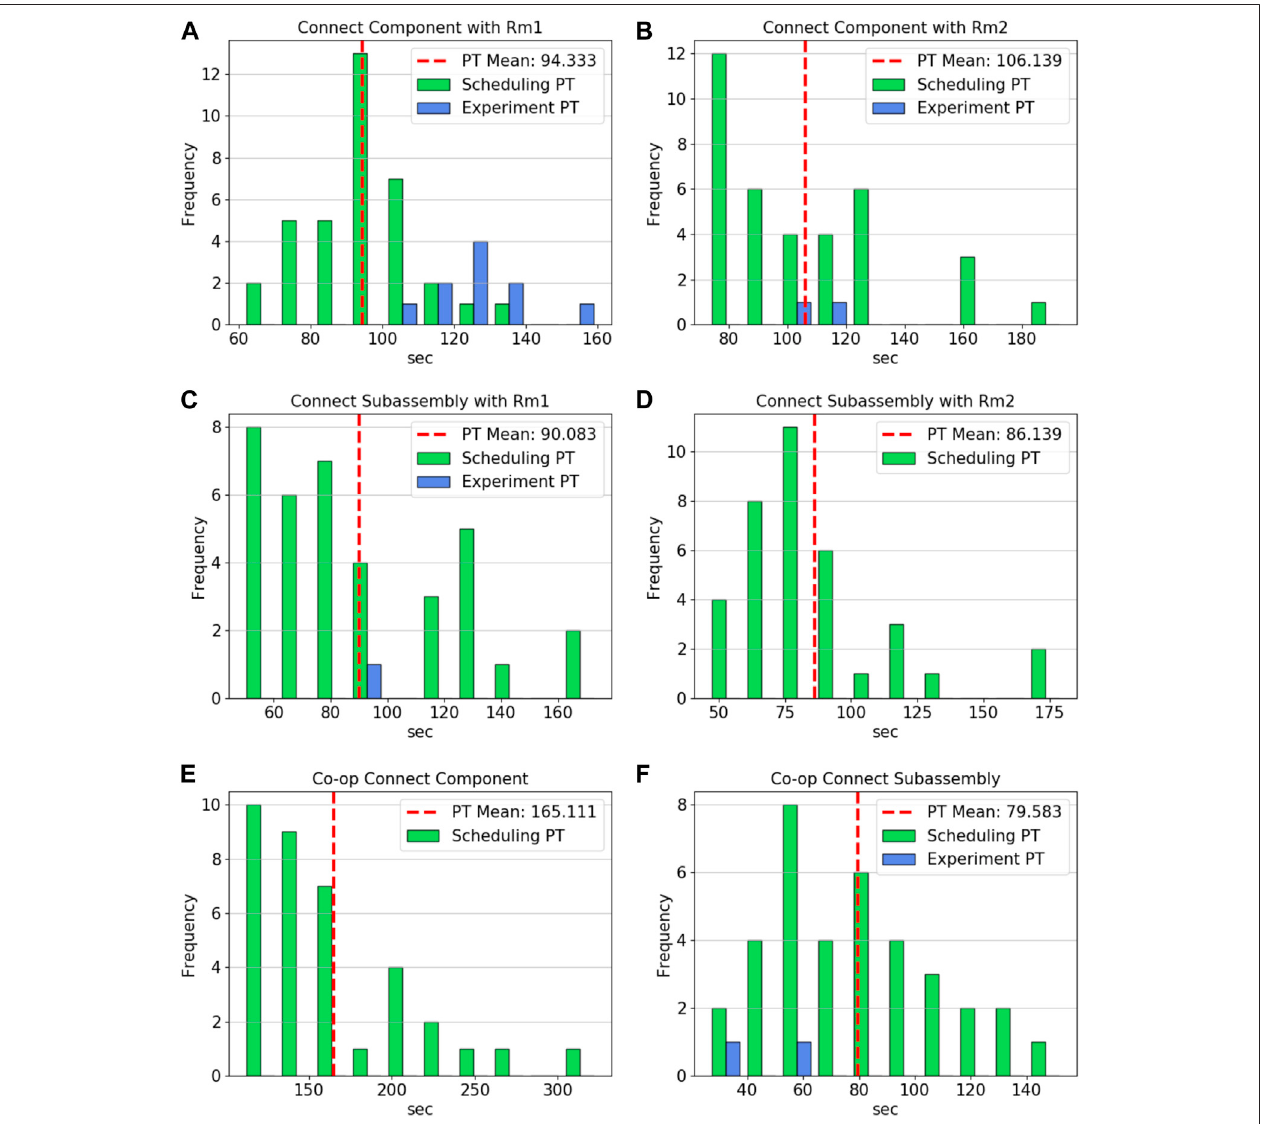
FIGURE 8 | (A) MARC 1 connect component processing times for scheduler and hardware instances, (B) MARC 2 connect component processing times for scheduler and hardware instances, (C) MARC 1 connect subassembly processing times for scheduler and hardware instances, (D) MARC 2 connect subassembly processing times for scheduler (there were no hardware instances), (E) Co-op connect component processing times for scheduler (there were no hardware instances), (F) Co-op connect subassembly processing times for scheduler and hardware instances.